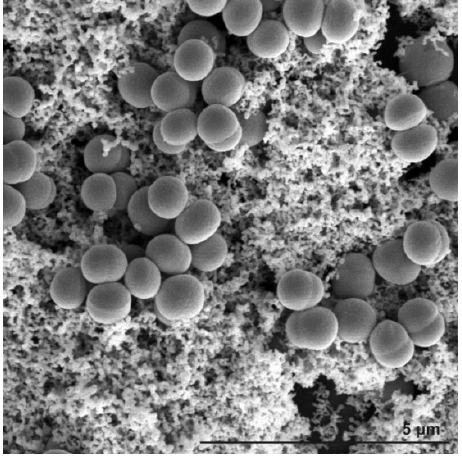
Figure 1. SEM image of Staphylococcus epidermidis grown on a glass substrate. Biofilm (slime) formation is clearly visible throughout the sample filling the space between grape-like clusters of Staphylococcus